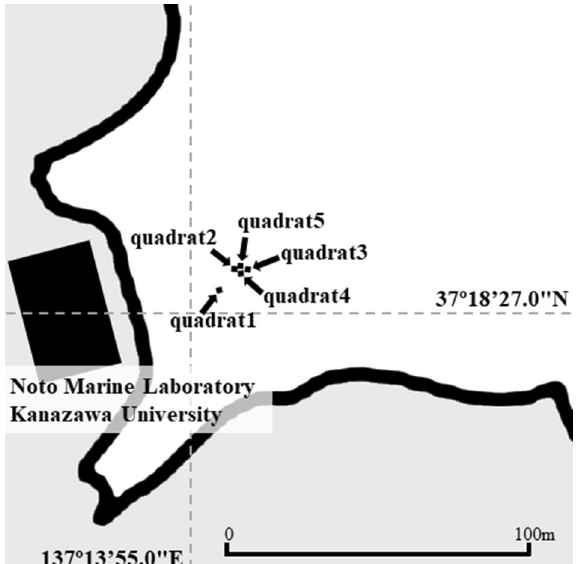
Figure 4. Survey points where the square frames were placed. The water depth at the observation site was approximately 11–13 m, although it changed depending on the tide